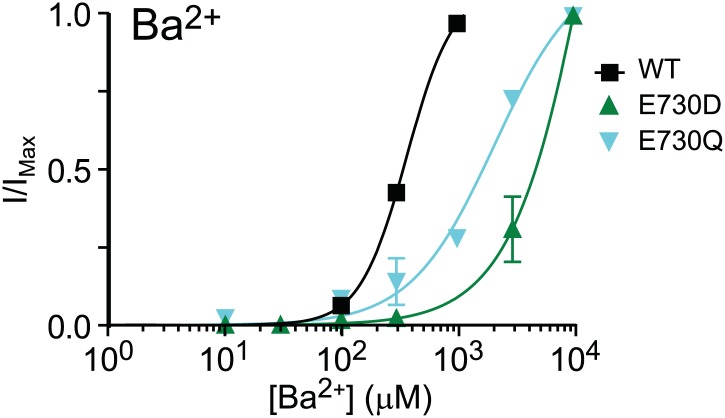
Barium dose-response curve of wildtype and mutant mTMEM16A channels at +60 mV. E730D and E730Q were the only mutants that produced appreciable activity out of the channels tested.The pattern of bariumdependentactivation is not similar to that of cadmium-dependent activation.